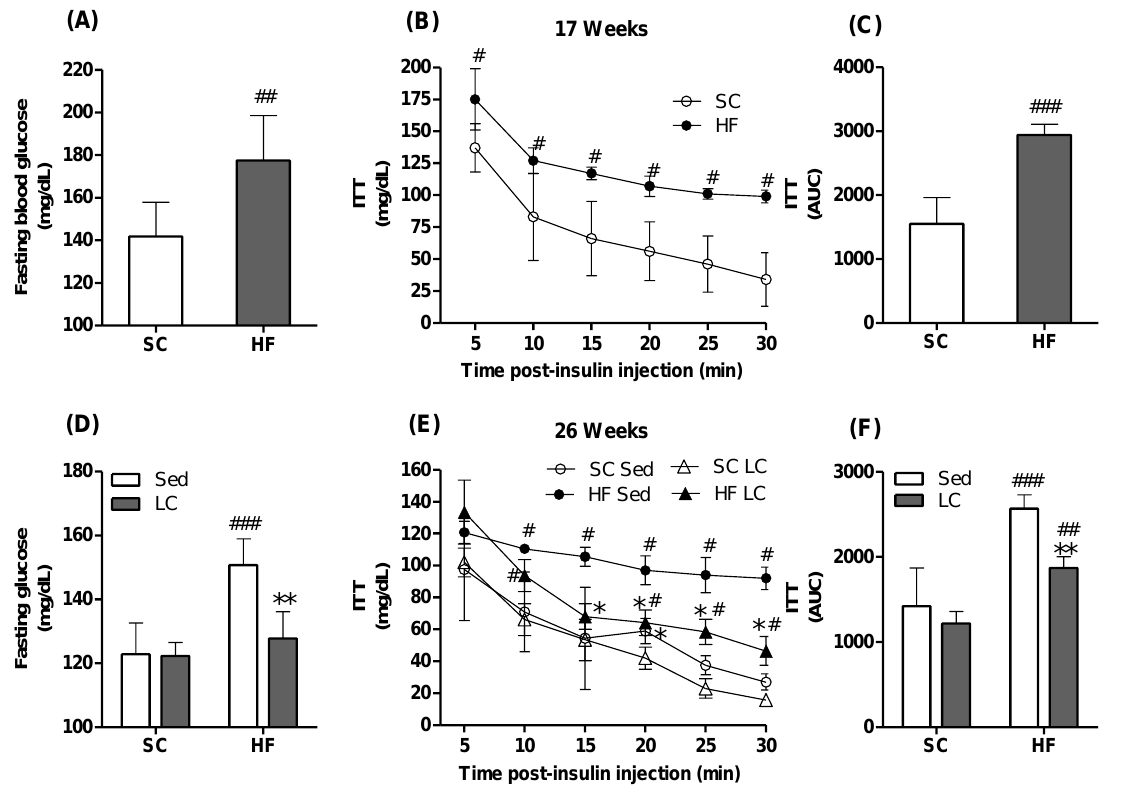
Figure 3. Effects of 17 weeks of HF feeding, followed by 8 weeks of LC on fasting glycemia ( A ) and ( D ), insulin-stimulated blood glucose clearance (insulin tolerance test, ITT, ( B , E ) and respective areas under the curve ( C , F ). Student ´ s t -test ( A – C ). Two-way ANOVA with Bonferroni posthoc test ( D – F ) ( n = 4). * p < 0.05, ** p < 0.01 vs. respective sedentary (Sed) group; # p < 0.05, ## p < 0.01, ### p < 0.001 vs. respective standard chow (SC) group.